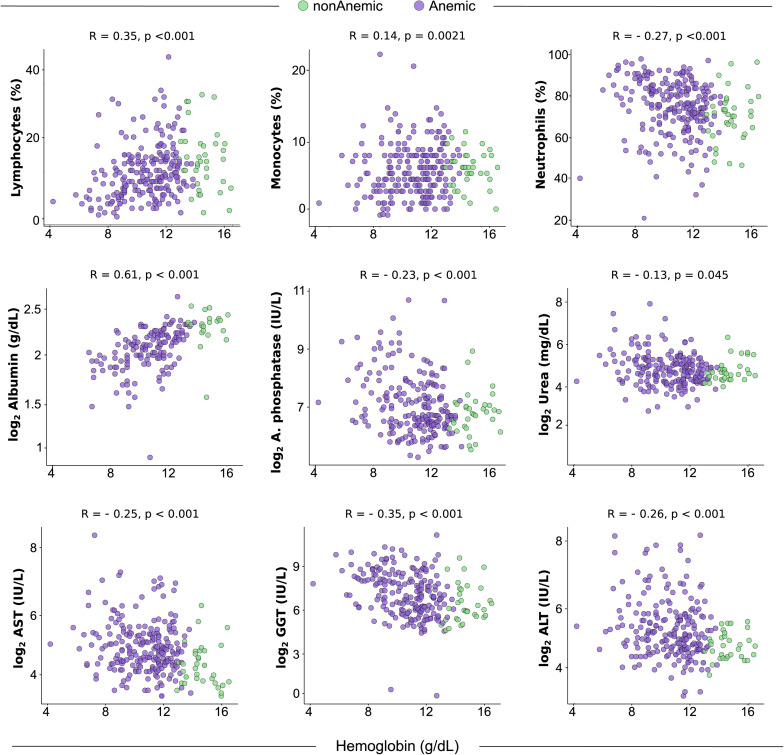
Spearman correlation analysis of cells and biochemical parameters versus hemoglobin in blood of TB-HIV prior to antitubercular treatment initiation. Plots from statistically significant Spearman correlations between biochemical parameters and hemoglobin levels at study baseline (pre-ATT) are shown (n = 256). To define anemia according to baseline hemoglobin, the cut-off point of 12 g/dL for women and 13.5 g/dL for men was used. ALT, Alanine Aminotransferase; AST, Aspartate Aminotransferase.